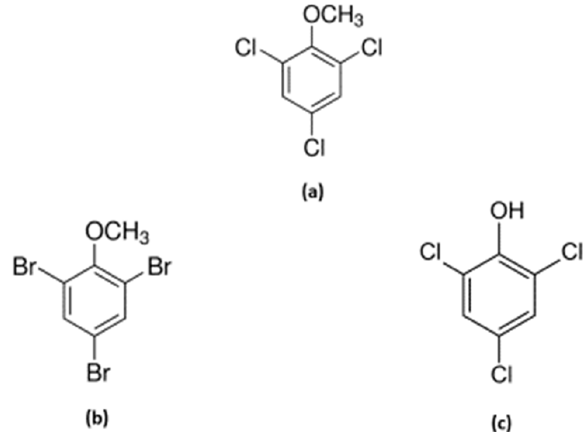
Figure 2. Structures of 2,4,6-trichloanisole (2,4,6-TCA) ( a ) and the structurally related/co-occuring 2,4,6- tribromoanisole (2,4,6-TBA) ( b ) and 2,4,6-trichlorophenol (TCP) ( c ). 2,4,6-tribromoanisole (2,4,6-TBA) ( b ) and 2,4,6-trichlorophenol (TCP) ( c